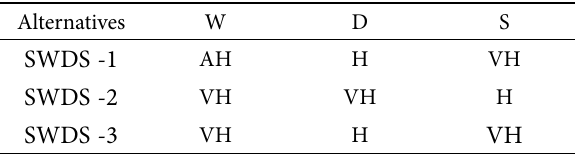
Table 6. Linguistic Decision Matrix